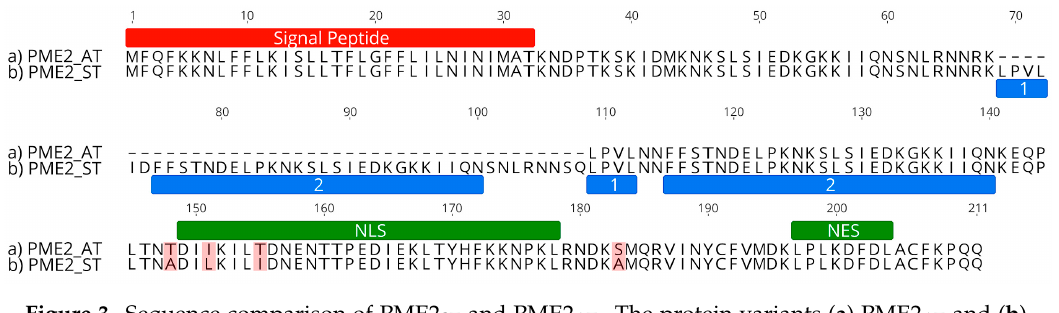
Figure 3. Sequence comparison of PME2 ST and PME2 AT . The protein variants ( a ) PME2 AT and ( b ) PME2 ST contain the same N -terminal signal peptide sequence (red). PME2 ST ( b ) contains a duplicated amino acid stretch (the replicative sequences 1 and 2; marked in blue) of a partial sequence also present in PME2 AT ( a ). Both variants show slight di ff erences in and directly before the nuclear localization signal sequences (NLS, green). The nuclear export signal sequence (NES, green) is identical in both protein variants. Amino acid di ff erences of PME2 ST to the PME2 AT variant are shown in black, whereas similarities are shown in grey. Graphs were generated with Geneious Prime 2018 version 11.1.4.